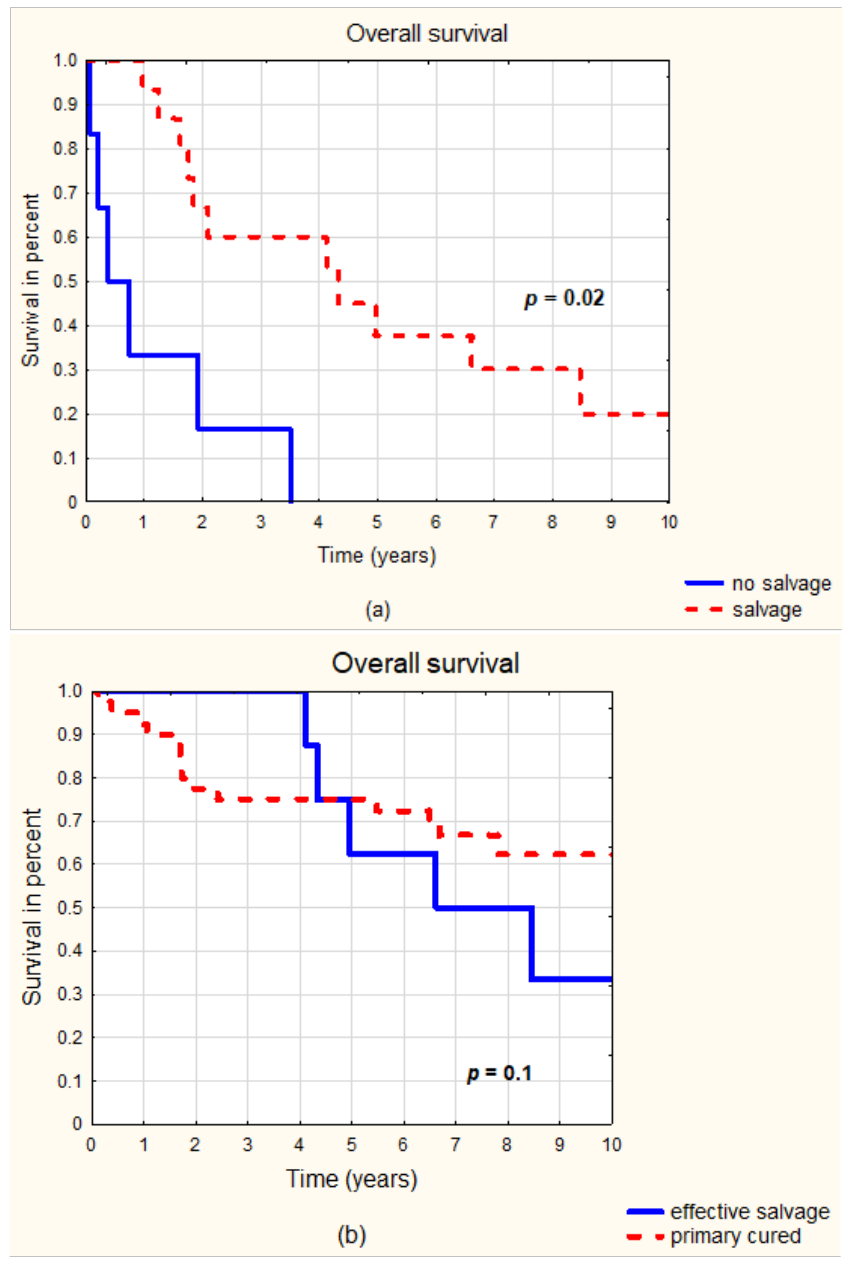
Figure 1. Overall survival considering salvage after primary treatment failure. ( a ) Patients with treatment failure: salvage vs. no salvage. ( b ) Patients cured primarily vs. cured after salvage.